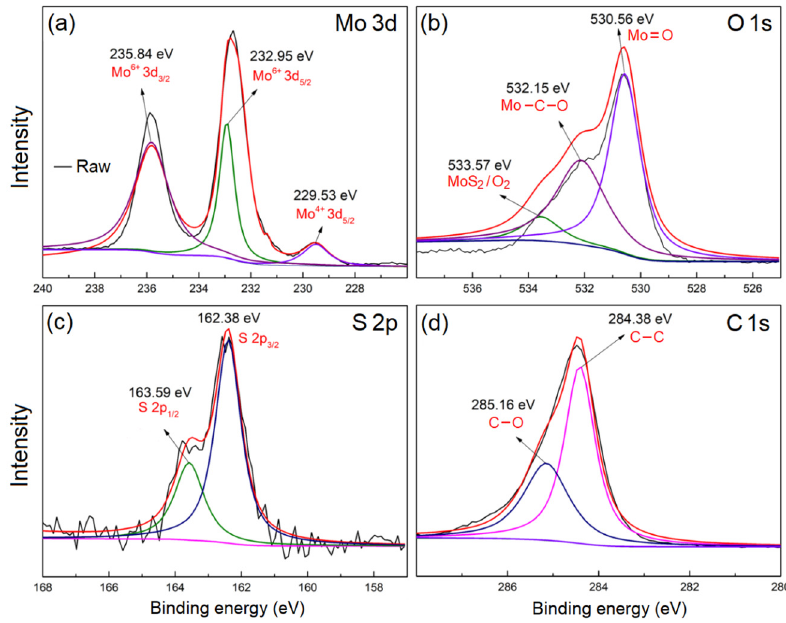
Figure 5. High resolution XPS spectra of MoO 3 /MoS 2 @G-1100, around ( a ) Mo 3d, ( b ) O 1s, ( c ) S 2p, and ( d ) C 1s peaks.